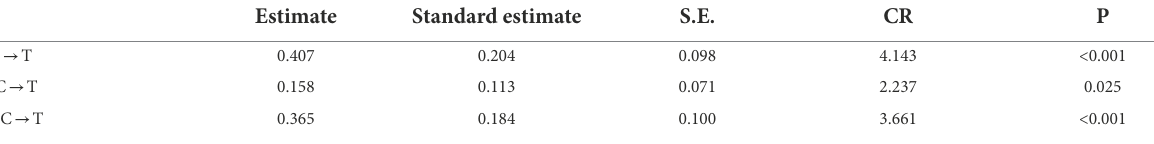
TABLE 4 Pathways from self-interest to tendency to commit fraud corresponding to Figure 3. Estimate